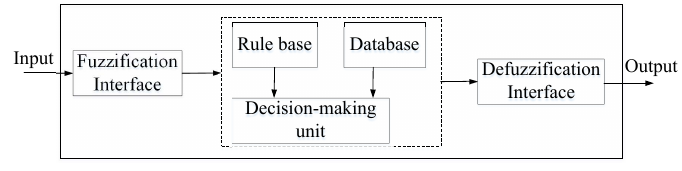
Figure 6. Structure of fuzzy